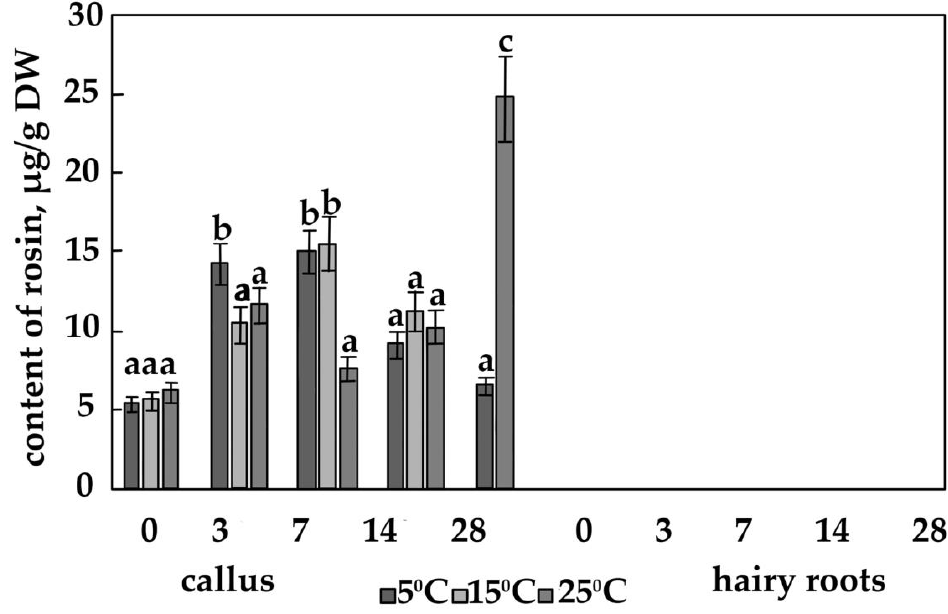
Figure 5. Rosin content in calli and hairy roots of R. quadrifida.